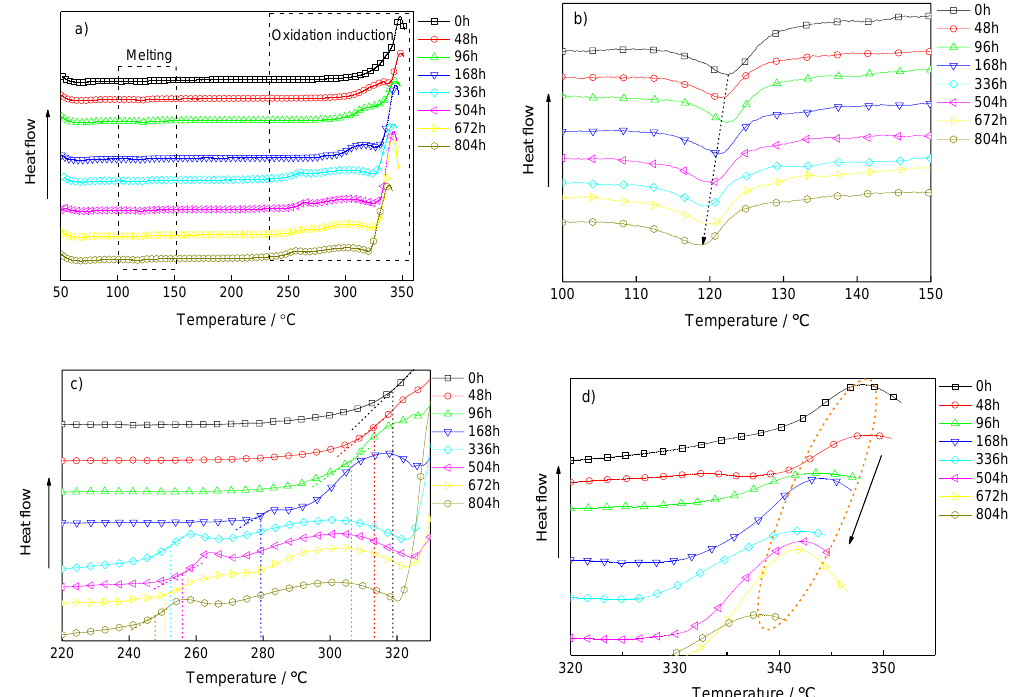
Figure 2. The e ff ects of aging on the melting and oxidative inducted behavior of the samples measured Figure 2. The effects of aging on the melting and oxidative inducted behavior of the samples by a di ff erential scanning calorimeter (DSC), ( a ) DSC curve in the whole heating process, ( b ) melting measured by a differential scanning calorimeter (DSC), a ) DSC curve in the whole heating process, b ) endothermic process, ( c ) the onset of oxidative-induced temperature (OIT), ( d ) the peak of melting endothermic process, c ) the onset of oxidative-induced temperature (OIT), d ) the peak of OIT.